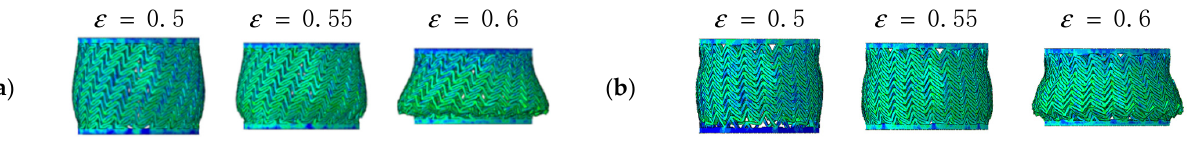
Figure 18. The deformation modes of A and B: ( a ) 30° RHCS; ( b ) 60° RHCS .